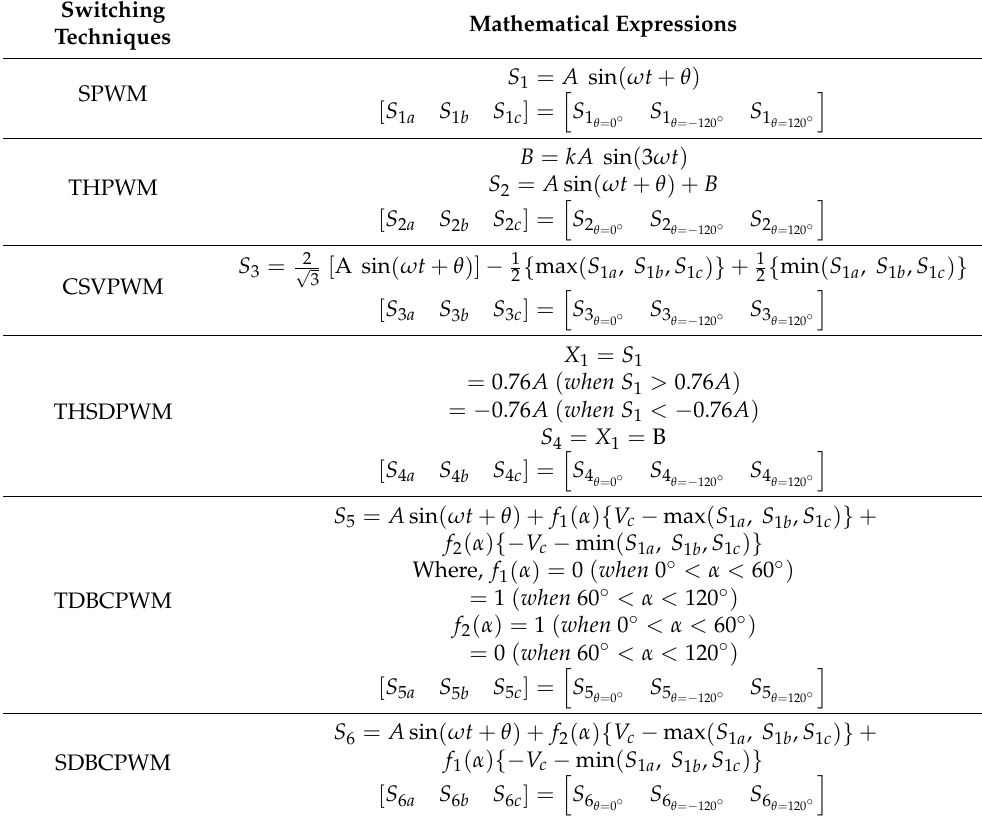
Figure 2. Modulating signals with the modulation techniques: ( a ) sine pulse width modulation (SPWM), ( b ) third harmonic-injected PWM (THPWM), ( c ) conventional space vector PWM (CSVPWM), ( d ) third harmonic sixty-degree PWM (THSDPWM), ( e ) thirty-degree bus clamping PWM (TDBCPWM) and ( f ) sixty-degree bus clamping PWM (SDBCPWM). Table 1 depicts the mathematical expressions of existing switching techniques. Table 1. Mathematical expression of existing switching technique.